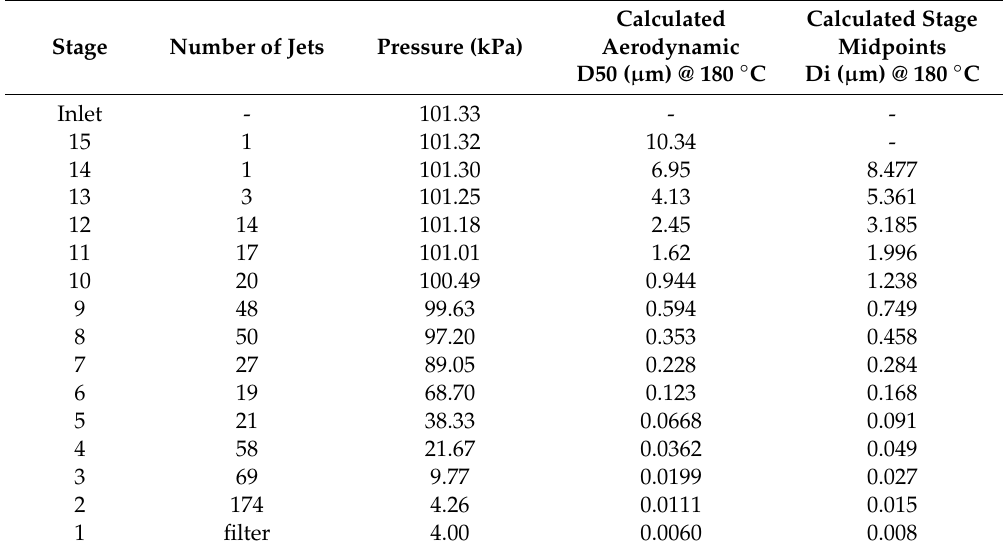
Table 3. Cut points and downstream stagnation pressures for DEKATI ® Impactor.